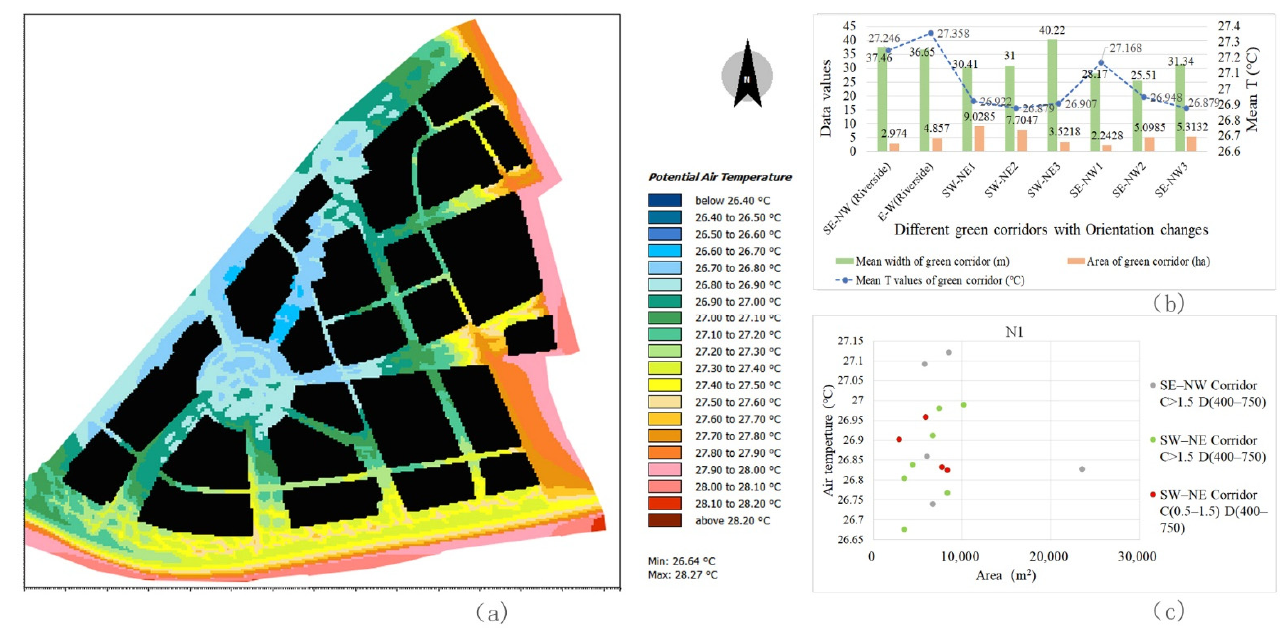
Figure 9. Ta distribution status of green corridors with different orientations at 14:00 and 1.5 m height in block N1 and comparison of the Ta difference of each green corridor segment. ( a ) Spatial distribution of Ta using ENVI-met simulation. ( b ) Comparison of mean temperatures of eight green corridors inside the block. The green corridor number is shown in Figure 2a. It can be seen that the green corridors with an SE–NW orientation have a lower Ta distribution. ( c ) Comparison of the Ta scatter distributions of two groups of green corridors with different orientations, the same grade of D factor and similar connection degree. It can be noticed that most Ta values of the green corridors with an SE–NW orientation are lower than those in the SW–NE oriented corridors. There are two outliers in the north location (these two green corridor segments are very narrow, independent of the radiating green space pattern and are independently located on the eastern edge of the block).